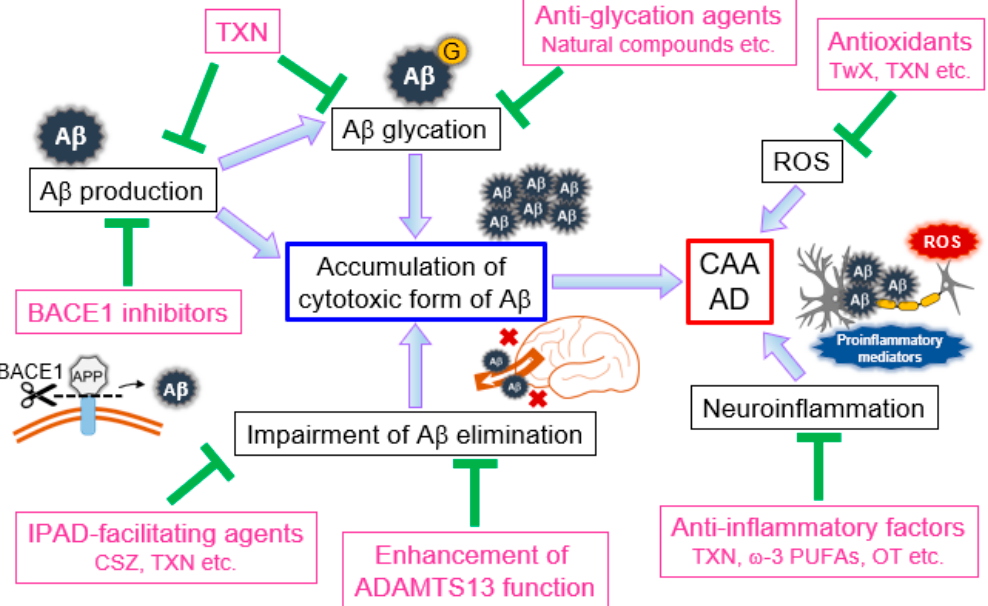
Figure 1. Pathological implications of amyloid- β (A β ), reactive oxygen species (ROS), and neuroinflammation and their role in potential therapeutic approaches for cerebral amyloid angiopathy (CAA) and Alzheimer’s disease (AD). A β produced in the brain aggregates to form fibrils,